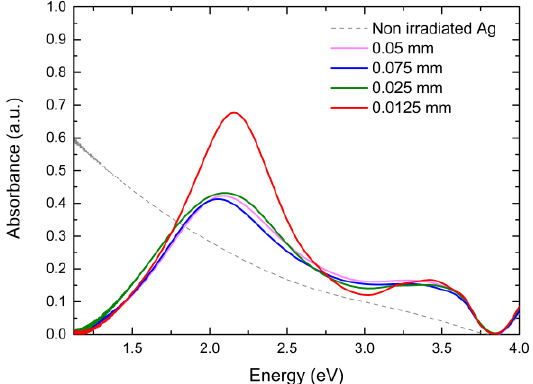
Figure 2. Absorbance spectra for areas of a 13.5 nm Ag film (Ag #1) irradiated with various fill spacing values at 60 kHz.